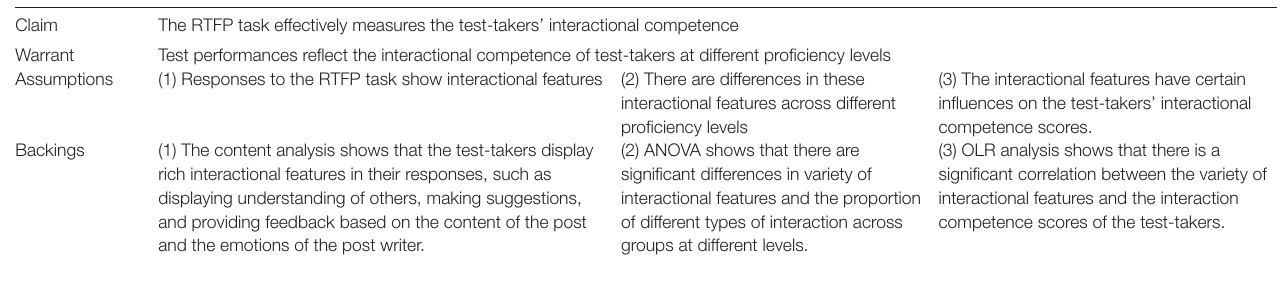
TABLE 7 | An argument-based validation for the RTFP